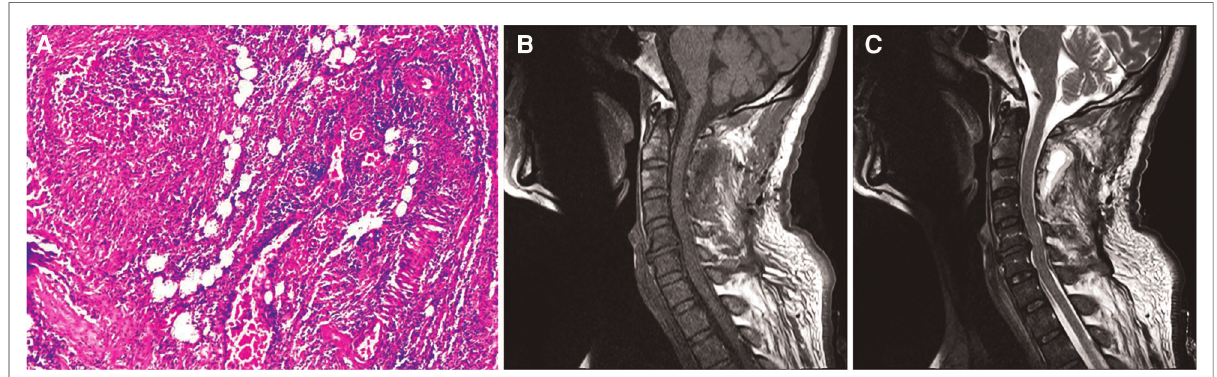
FIGURE 3 ( A ) microscopic examination of the sample tissue with HE staining revealed fi brous adipose tissue, in which a large number of acute and chronic in fl ammatory cell in fi ltrates with abscess formation, and vascular dilatation and hyperemia were observed. Picture was taken at 100 magni fi cation. ( B ) T1-weighted image of the cervical spine 21 days after the operation showed that the abscess signal in the spinal canal disappeared. ( C ) T2- weighted image of the cervical spine 21 days after the